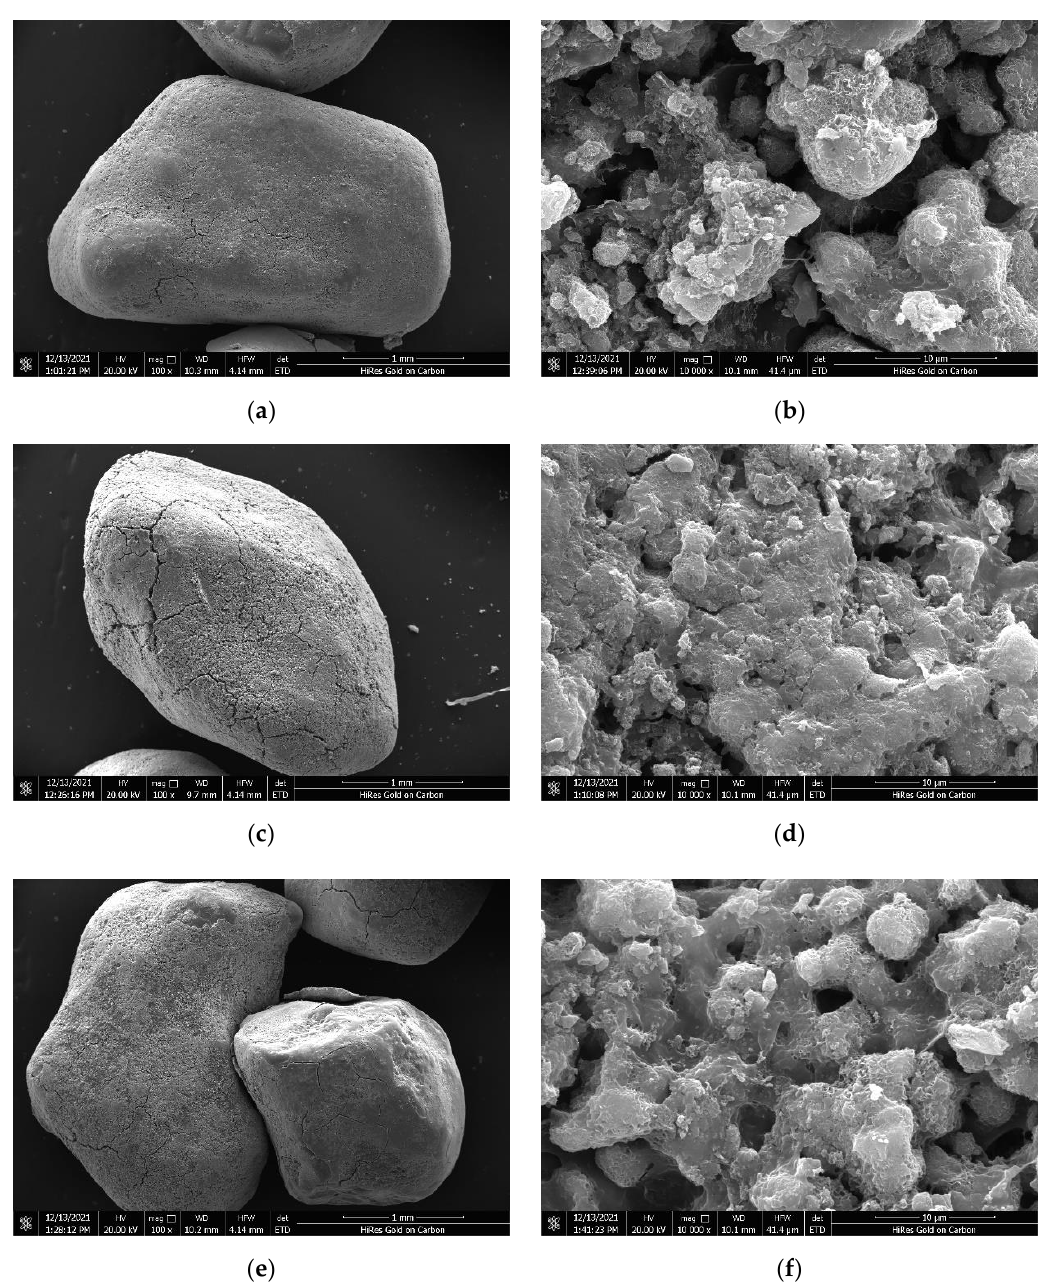
Figure 7. The morphology of the oxide film on the 1st, 47th and 90th day: ( a ) 1st day filter × 100, ( b ) 1st day filter × 10,000, ( c ) 47th day filter × 100, ( d ) 47th day filter × 10,000, ( e ) 90th day filter × 100, ( f ) 90th day filter × 10,000.